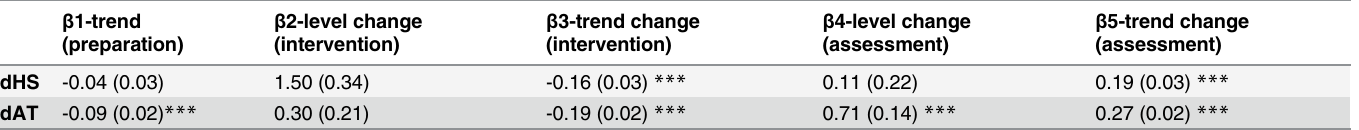
Table 3. Regression analyses of ITS on the changes in duration of hospital stay and peri-operative antibiotic treatment in the 4 types of clean